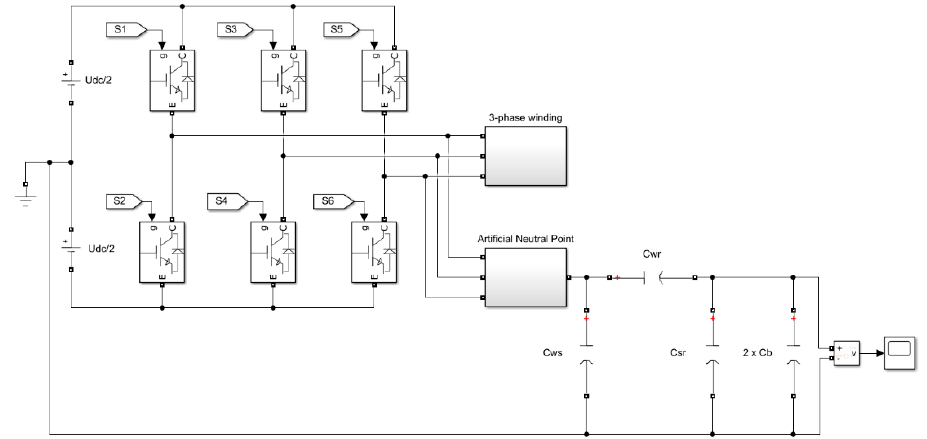
Figure 19. Diagram of a circuit model to simulate the bearing voltage u b